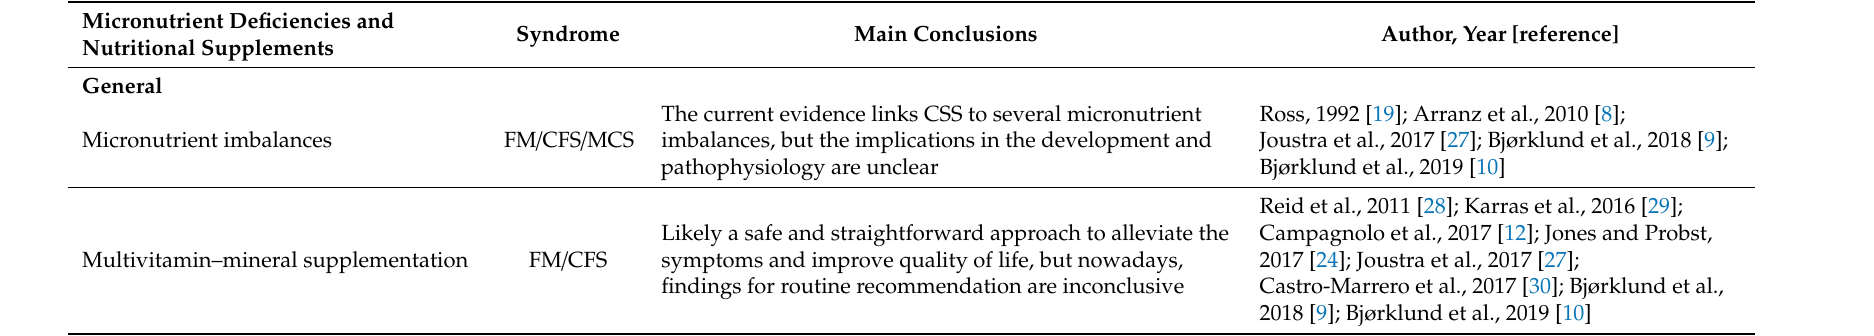
Table 2. Micronutrient deficiencies, nutritional supplements and main conclusions according to the